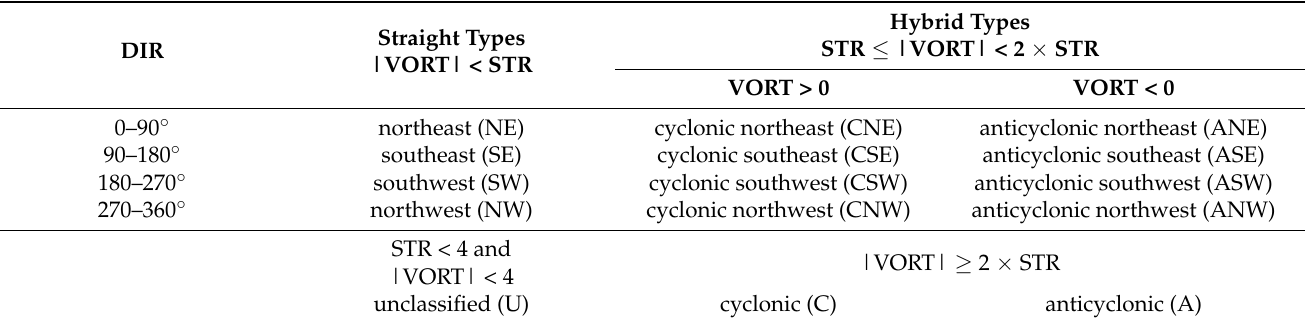
Table 3. Circulation type definitions and their